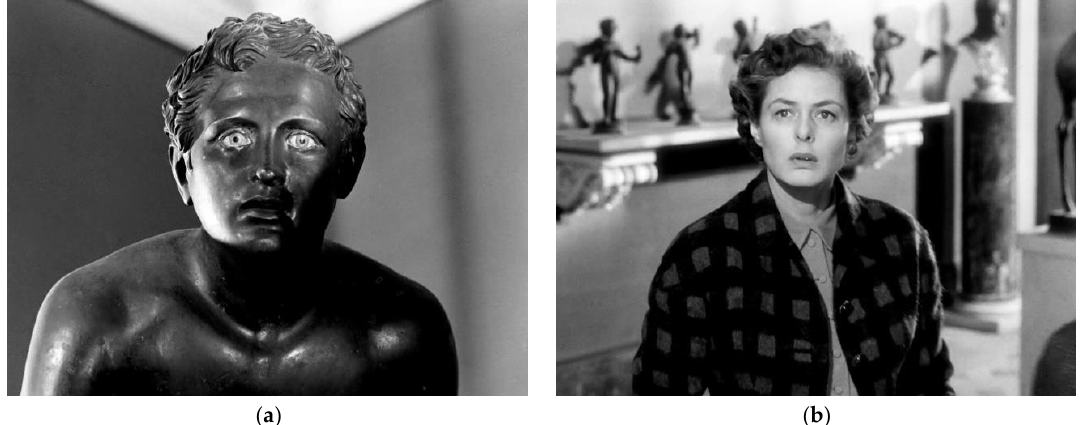
Figure 6. Frames from Journey to Italy . A tracking shot that closes in on a discus thrower whose painted eyes appear to stare directly into the camera lens ( a ), preceded by a similar camera movement that indicates where Ingrid Bergman view is directed ( b ). Source: Blu-Ray edition by The Criterion Collection (USA).